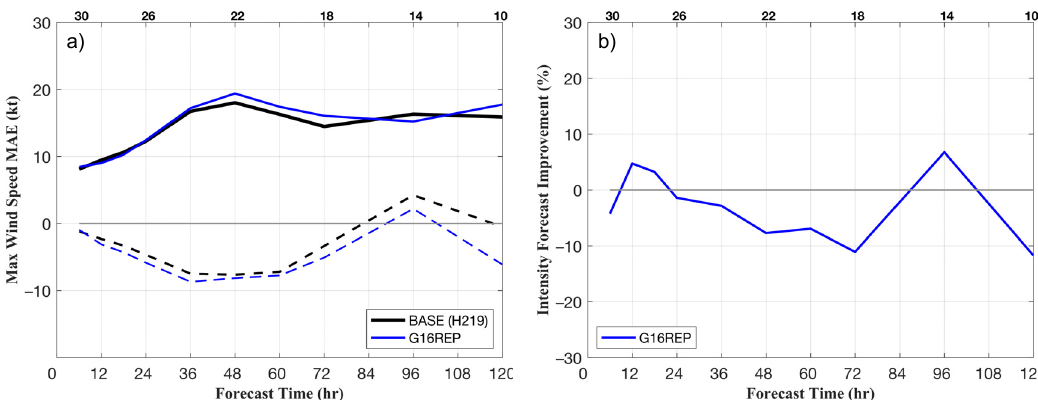
Figure 5. Hurricane Irma (2017) HWRF intensity (maximum wind speed, kt) forecast MAE (solid) and bias (dashed) verified against NHC Best Track for BASE (heavy black line) and G16REP (blue line) in ( a ). Percentage improvement in MAE relative to BASE is shown in ( b ). The number of verifying forecasts for each lead time is shown in black across the top of each plot.